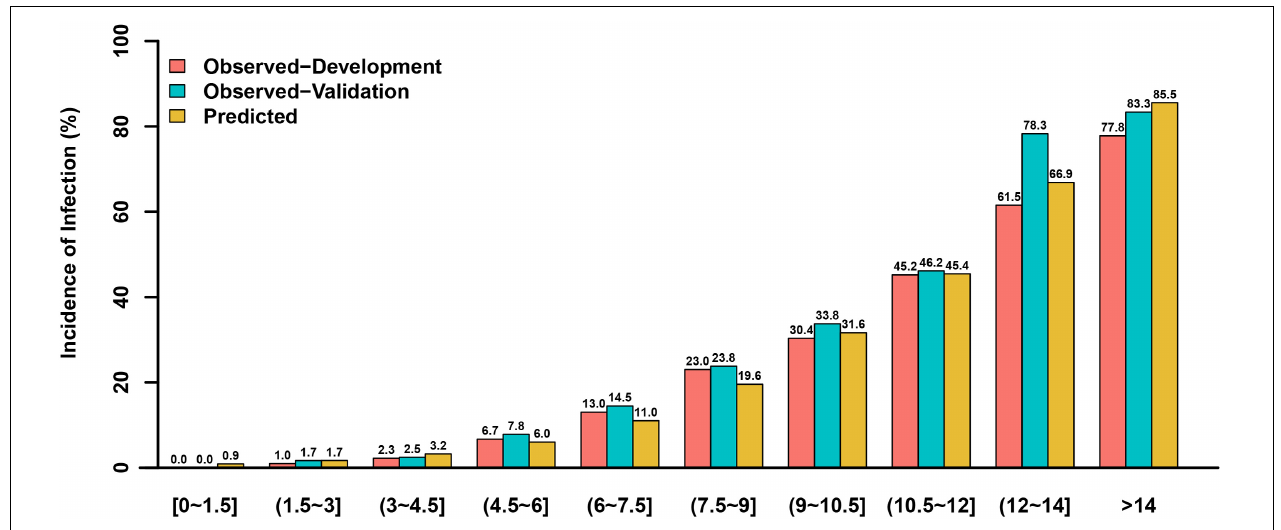
FIGURE 3 | The observed and predicted incidences of post-AMI infection in the development and validation cohorts based on different risk